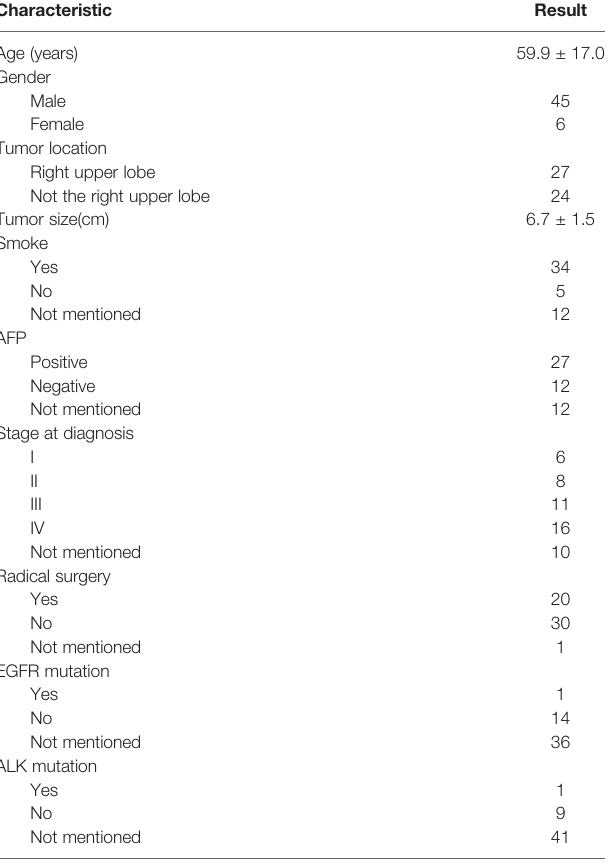
TABLE 2 | The clinical characteristics of 51 cases.